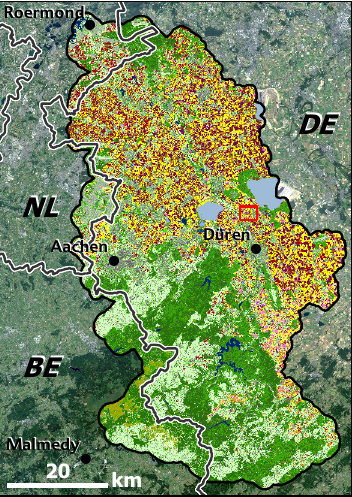
Figure 1. Land use overview of the Rur catchment.